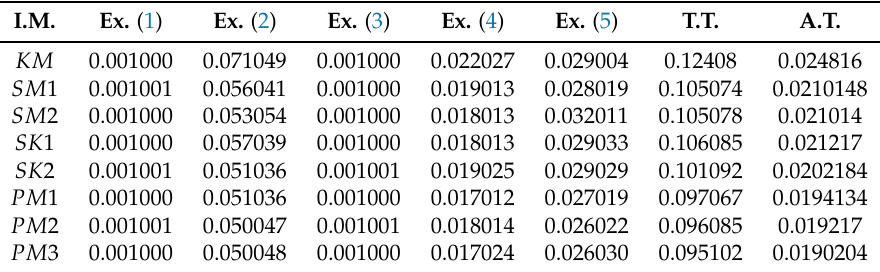
Table 3. CPU timing of different iteration